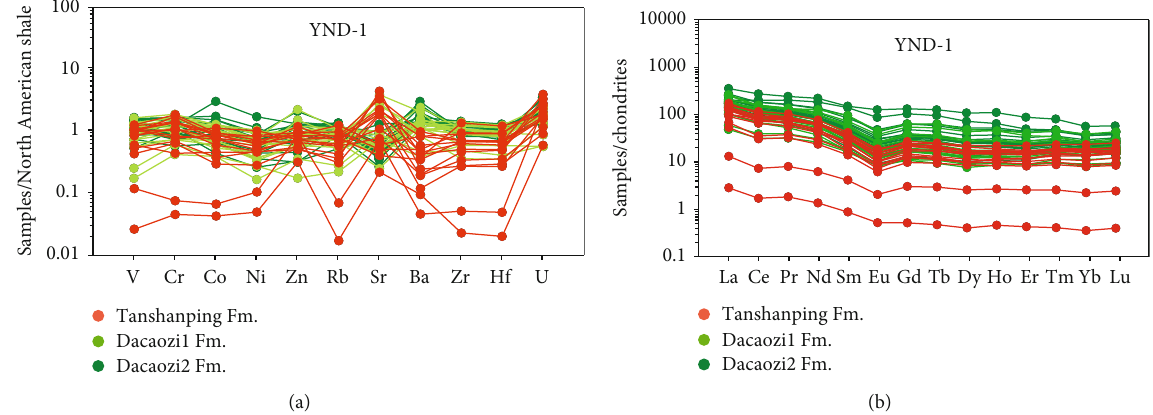
Figure 4: North American shale composite (NASC) normalized (for trace element) and chondrite normalized (for REE) diagrams for samples from the Middle Devonian Tanshanping Formation and Dacaozi Formation in the Ninglang-Yanyuan Basin, Southwest